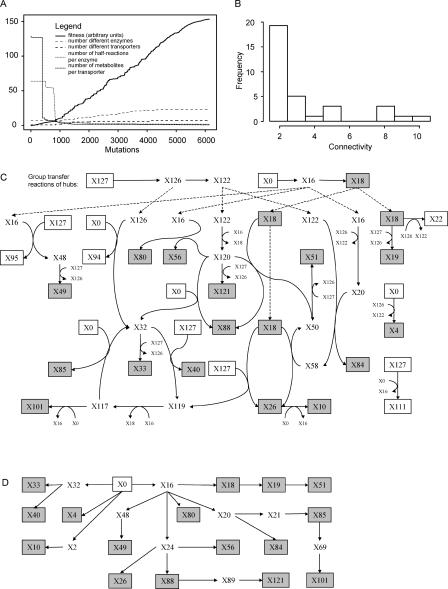
Sample Simulation for the Evolution of Metabolic Networks(A) The initial network consists of 128 metabolites, seven unspecific enzymes (each of which transfers one of the seven biochemical groups that metabolites carry), and a single unspecific transporter. Within the course of evolution, the enzymes and transporter duplicate and increase in specificity (i.e., the number of half-reactions per enzyme and of metabolites per transporter decreases). The emerging network consists of 23 enzymatic reactions and seven transport processes. In the sample simulation, all enzymes and transporters in the emerging network are highly specific, i.e., the enzymes catalyze only two half-reactions, and the transporters transport single metabolites. The emerging network contains only 33 metabolites. The remaining metabolites are not involved in the emerging network.(B) Connectivity distribution of the emerging group transfer network. Most metabolites are involved in only two reactions. However, a few metabolites are highly connected.(C) Pathway scheme of the emerging group transfer network. The metabolites X0 and X127 are taken up from the environment, whereas metabolites X4, X22, X94, X95, and X111 are excreted into the environment (white boxes). The network eventually transforms metabolites X0 and X127 into those metabolites that are involved in biomass formation (grey boxes). Interestingly, metabolite X4 is excreted although it is involved in biomass formation. Note that some half-reactions evolve, such as the one from X127 to X126, and monopolize the transfer of a specific group (in this case the first group in the binary string). These metabolites are involved in many reactions and therefore have high connectivity. The group transfer reactions of these hubs are summarized in the first line of the pathway scheme. The emerging group transfer network is much more complex than the corresponding monomolecular reaction network (see Figure 2D) and even includes a cycle (X32 → X119 → X117 → X32), with the net reaction of X0 + X16 + X127 → X18 + X40 + X85).(D) Pathway scheme of an emerging monomolecular reaction network. Although the network produces the same set of metabolites involved in biomass formation as the group transfer network shown in Figure 2C, it has a much simpler, tree-like structure. Additionally, the network has no obvious hubs.